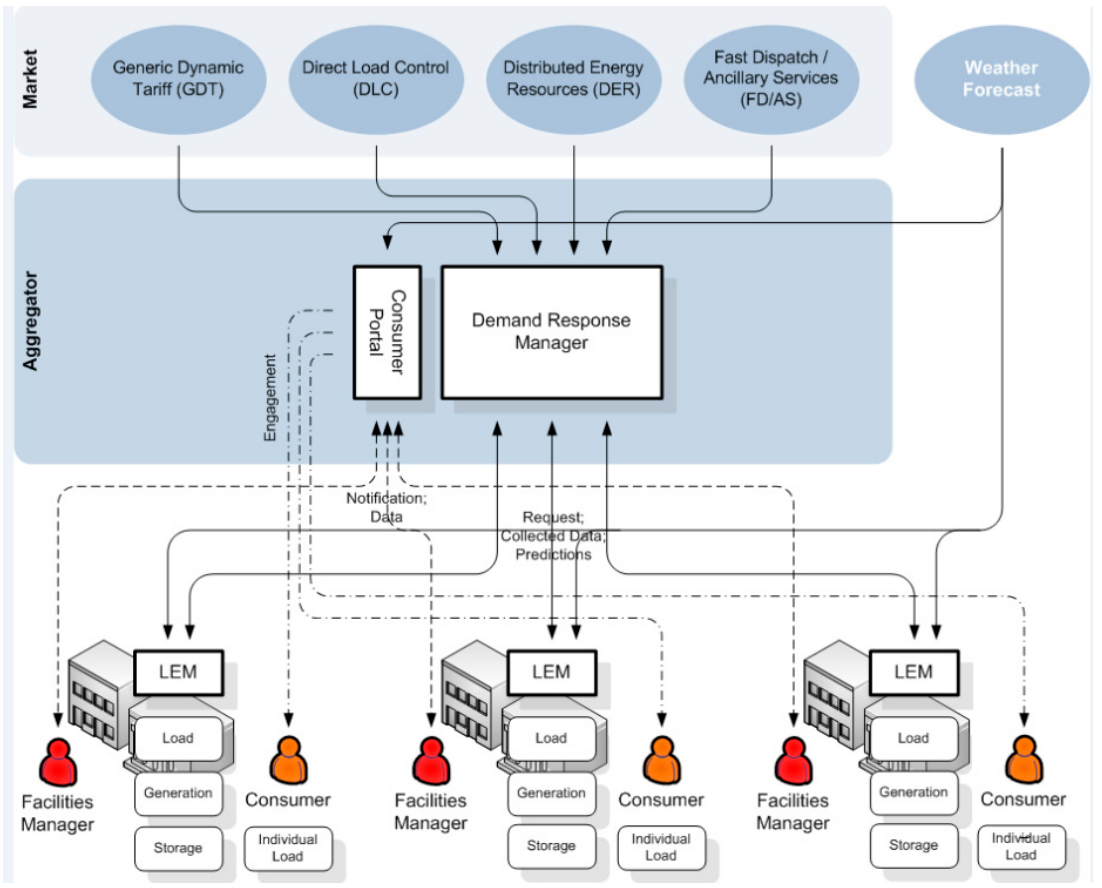
Figure 1. DR-BoB Energy Management Solution.